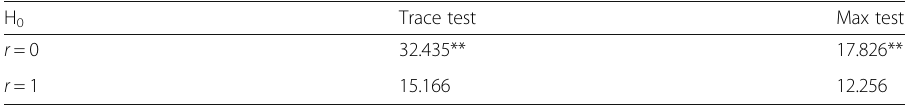
Table 5 Cointegration test based on the trace and max tests H 0 Trace test